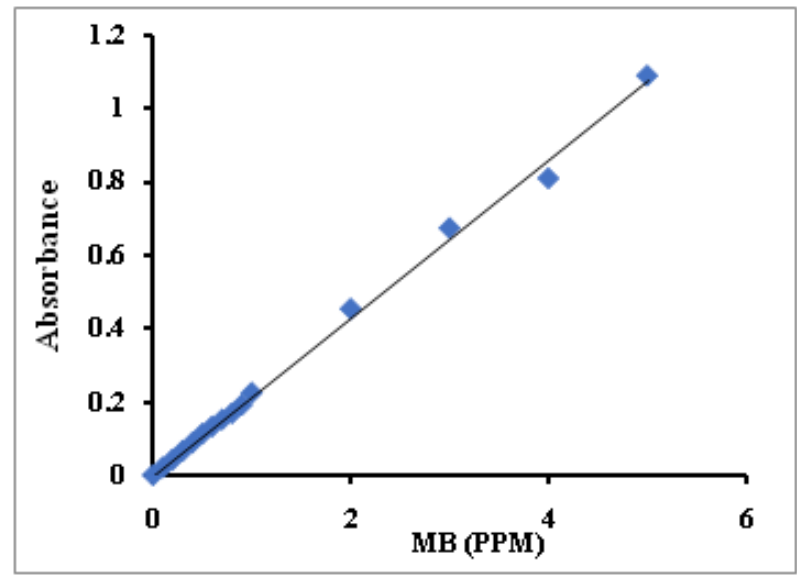
Figure 1. Standard curve for MB